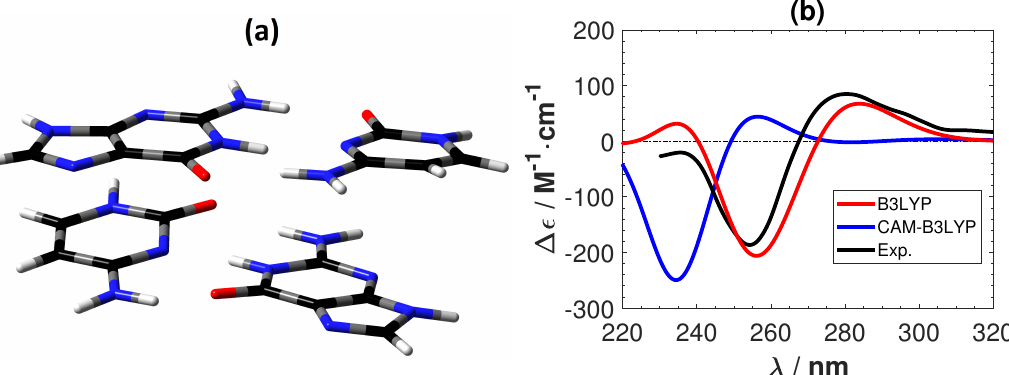
Figure 6. ( a ) The structure of a plain B-DNA tetramer. The color of atoms : O: red, C: black, N: blue and H: white. ( b ) The corresponding calculated and experimental [48,49] ECD spectra. No shifting of the calculated spectra are done.